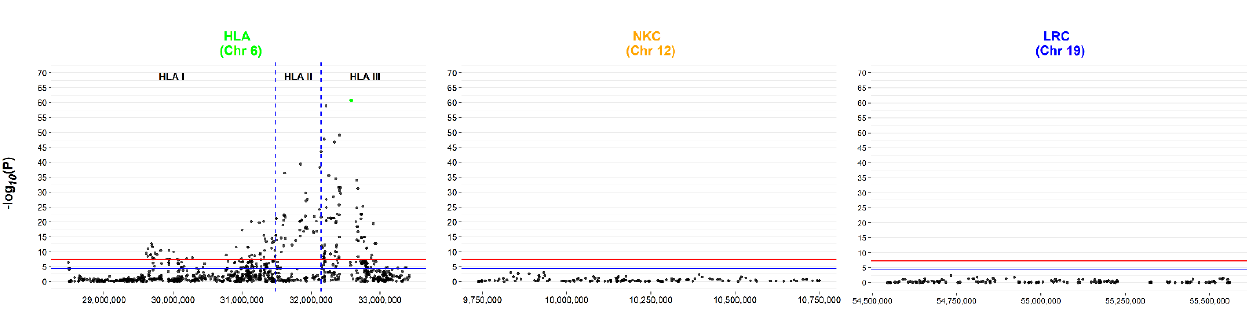
Figure 2. Conventional GWAS case vs. control analysis of the discovery dataset reveals no hits outside of the HLA loci. Manhattan plot for the HLA, NKC and LRC regions, using the log10 transformed P value from Fisher’s Exact testing against base position for the pre-imputed ANZgene dataset. The HLA loci contains SNPs reaching the gold standard GWAS Bonferroni correction threshold of 5 × 10 − 8 (red line), with two distinct peaks across the region. In contrast, neither the NKC nor the LRC loci contained SNPs that met the relaxed Bonferroni correction of 4 × 10 − 5 (blue line) accounting for the number of SNPs analysed. The SNP highlighted in green is the tag SNP for the drb15 haplotype. Table 2. Comparison of the five SNPs with the lowest P value (2sf) from each loci, using Fisher’s exact testing on the ANZgene dataset. When using Bonferroni correction only SNPs below 5 × 10 −8 or 4 × 10 −5 would be considered ‘significant’, representing the gold standard for GWAS or relaxed relative to the number of SNPs analysed, respectively. SNPs, in bold and with an adjacent asterisk, denote those that met the elastic model threshold (Table 3).